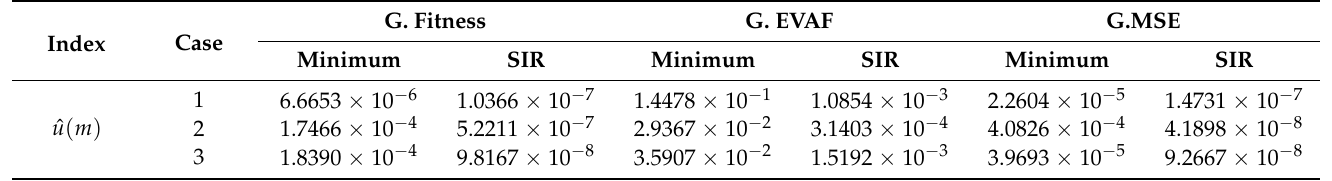
Table 4. Global performances of the mathematical form of the